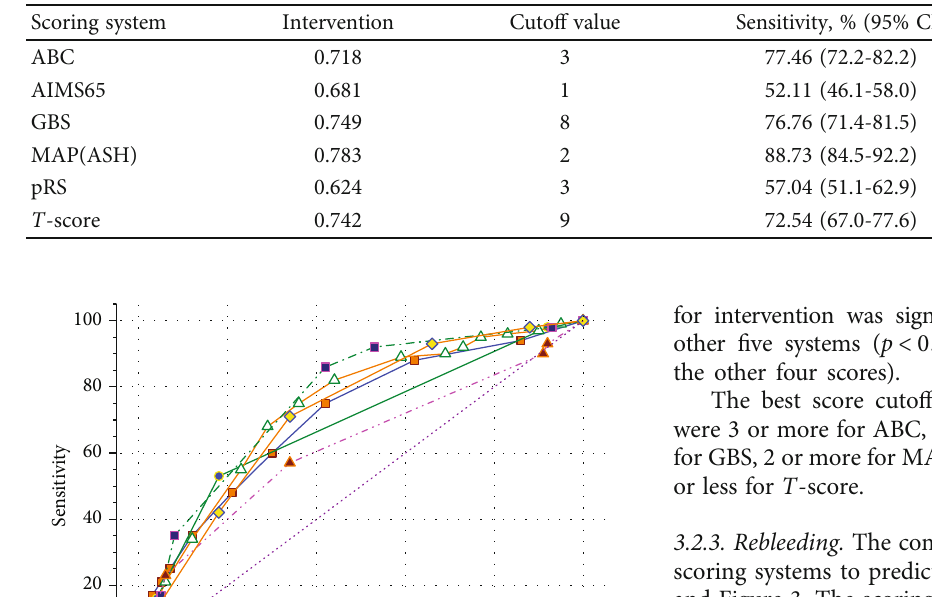
Table 5: Values of the six scoring systems in prediction of intervention.